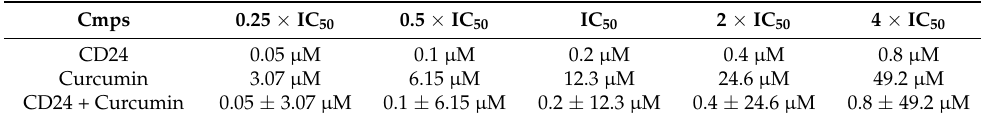
Table 1. Five selected doses for the combination experiments of CD24 + curcumin.